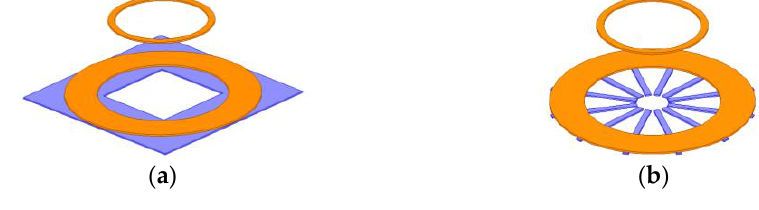
Figure 7. Two ferrite structures. ( a ) flat type and ( b ) strip type.